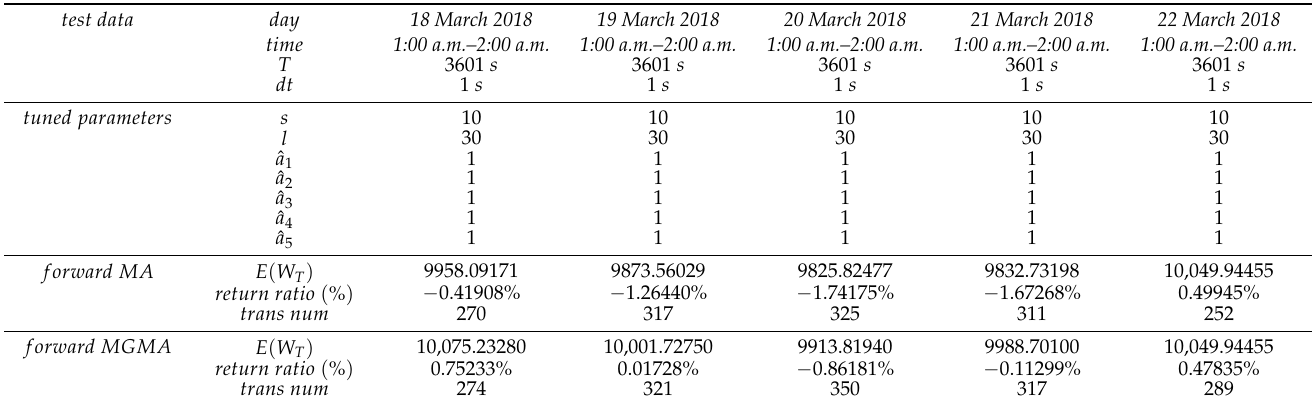
Table 11. Case 2—MGMA strategy evaluation summary for HuaXia ETF and HuaTai ETF on day 1